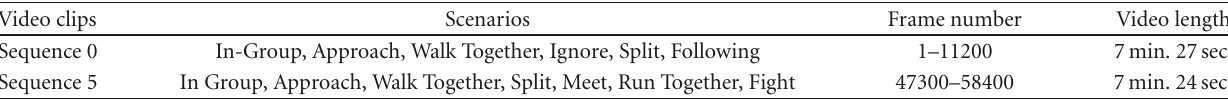
Figure 10: Activity examples in the BEHAVE dataset: (a1)–(a6) scenarios in the Sequence 0; (b1)–(b3) three activities in Sequence 5, which are abnormal with respect to Sequence. Table 5: The scenarios of the learning and testing sequences for the BEHAVE dataset.